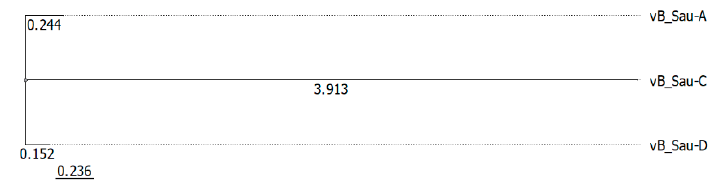
Figure 6. Whole genome phylogeny of selected kayviruses and newly isolated bacteriophages described in this work. 4. Discussion Phage therapy is seen as a more cost-effective alternative to the isolation and development of new antibiotics against multidrug-resistant nosocomial pathogens such as MRSA [32]. Phages can be found in all habitats and be isolated relatively easy and at low cost. Furthermore the use of phages lacks serious side effects on eukaryotic cells, that some antibiotics may cause [4,32]. However, an in-depth characterization of isolated phages is required in order to assess their therapeutic potential against clinical isolates of pathogenic bacteria. In the last decade, several